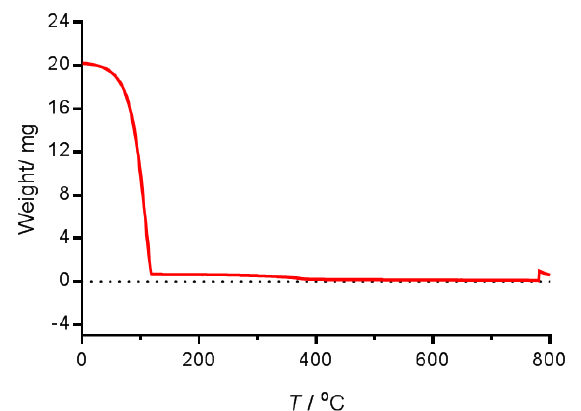
Figure 2. Thermogravimetric analysis of the nanoemulsion obtained by the LE method. The measurement was made from room temperature up to 1000 °C under nitrogen atmosphere (flux of 50 mL min − 1 ) with a 10 °C min − 1 heating rate.